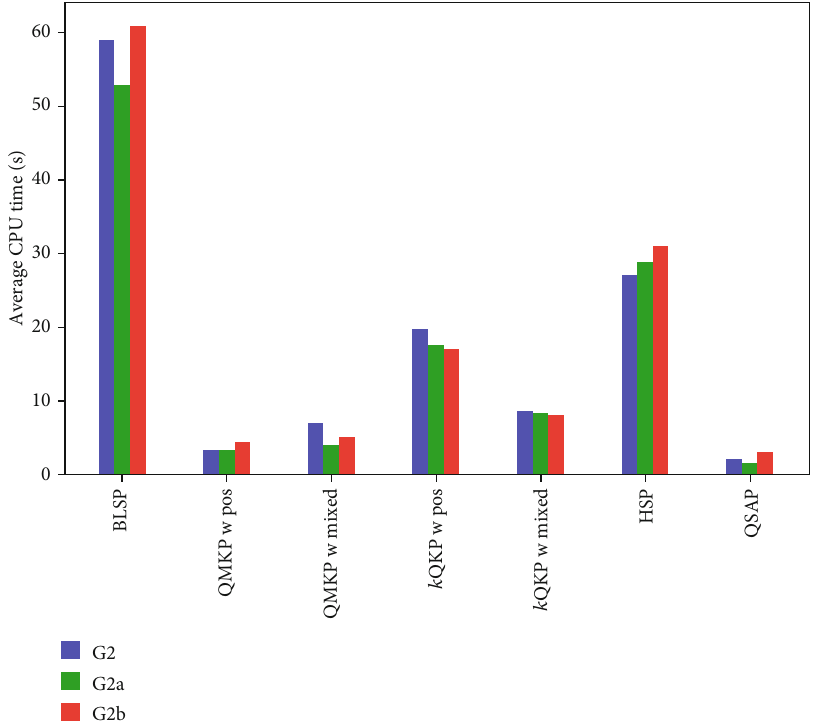
Figure 6: Average CPU times (s) for Question